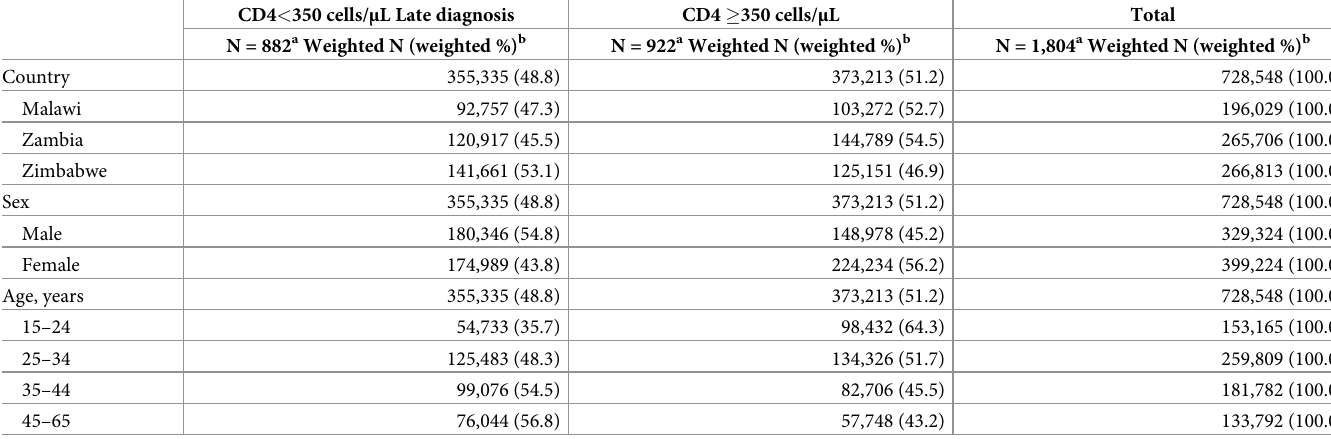
Table 2. Prevalence and weighted number persons with late diagnosis of HIV during the survey in Malawi, Zambia, and Zimbabwe (2015–2016).